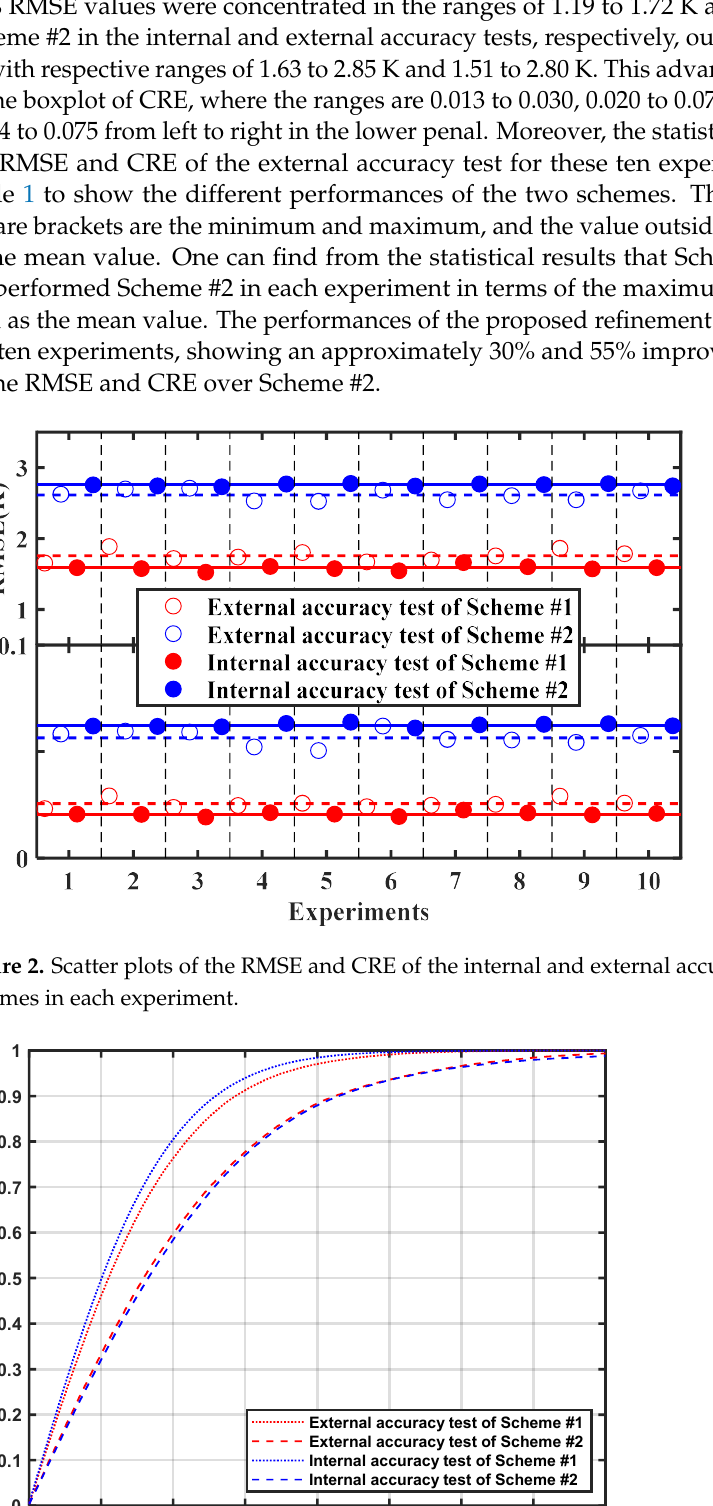
External accuracy test of Scheme #1 External accuracy test of Scheme #2